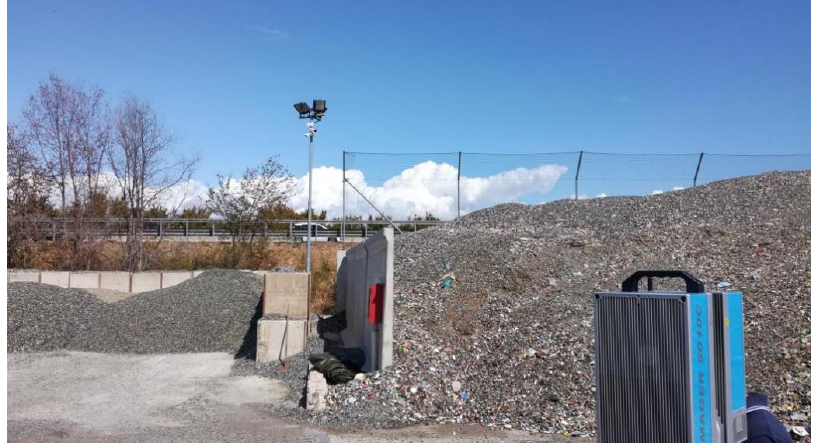
Figure 2. Laser scanner survey of the waste stockpile.